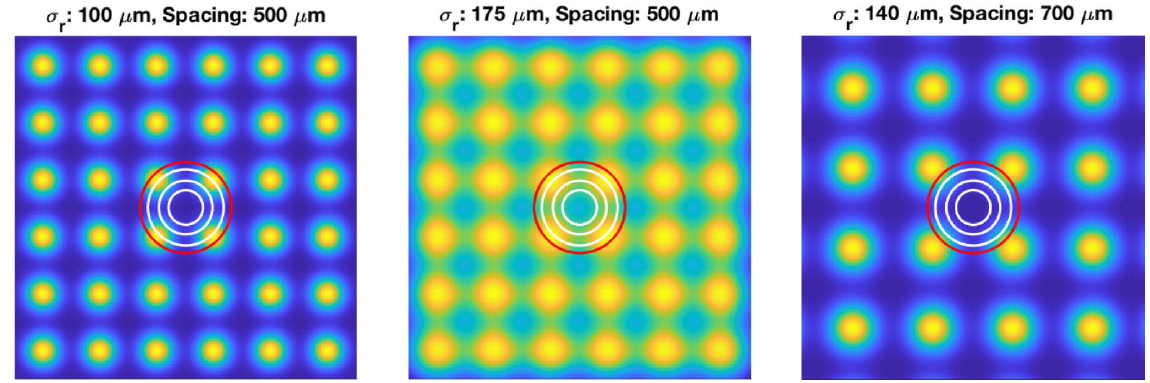
FIG. 4. Illustration of BA profile with various fill and spacing factors. The left profile shows the ideal parameters determined by sweeping. The center panel shows an increased fill factor, while the right shows larger